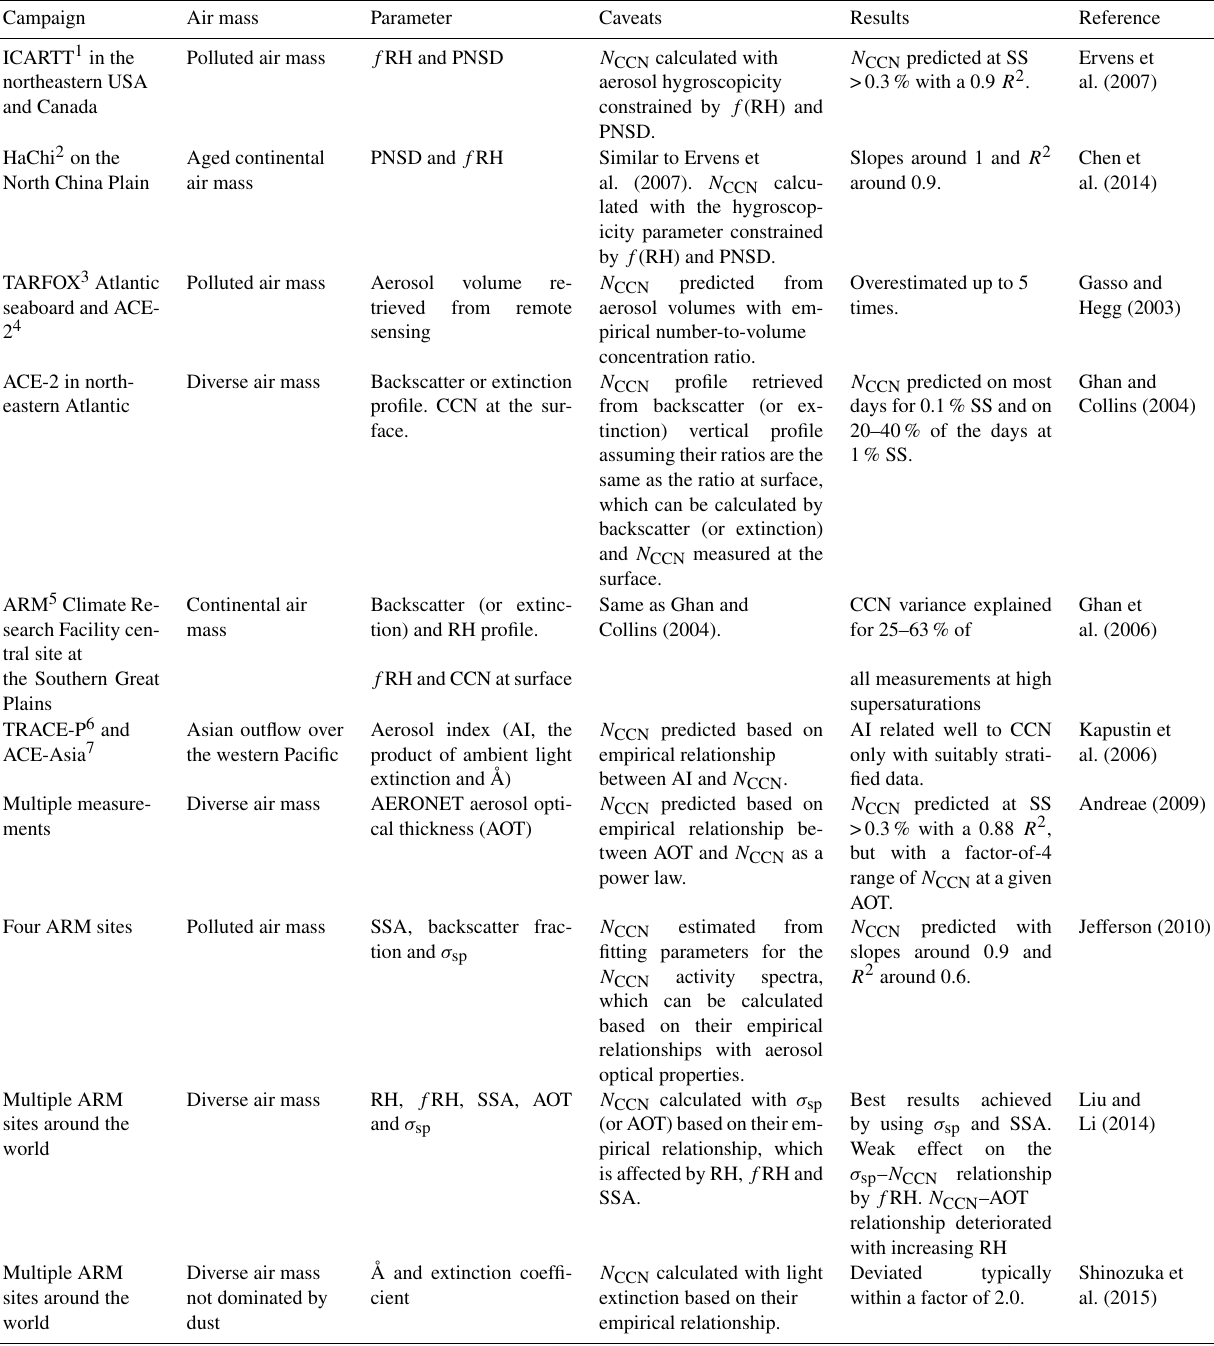
Table 1. Review of studies that have used aerosol optical parameters to infer N CCN